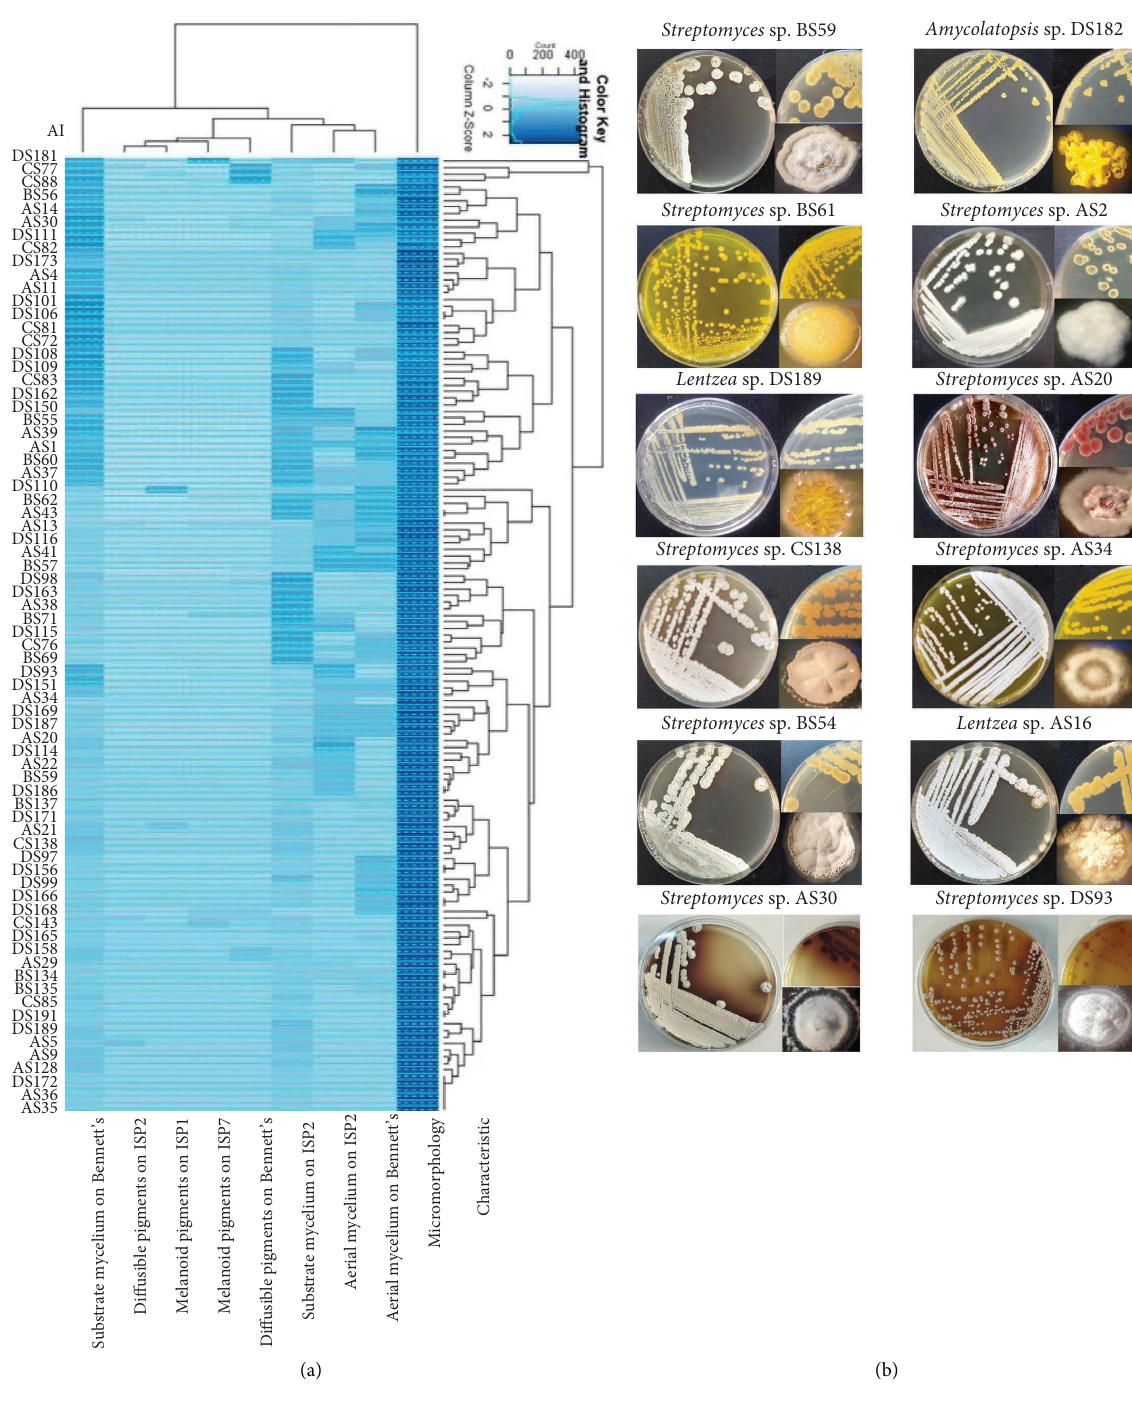
Figure 3: Diversity of culturable Actinobacteria isolated from lead mine sites. (a) Dendrogram showing the clustering of 145 actinobacterial isolates based on their morphological characteristics. AI: Actinobacteria isolate. (b) Phenotypes of some actinobacterial isolates: for each example, the front and back of the agar plate-grown bacteria are both denoted with the phenotype of a single